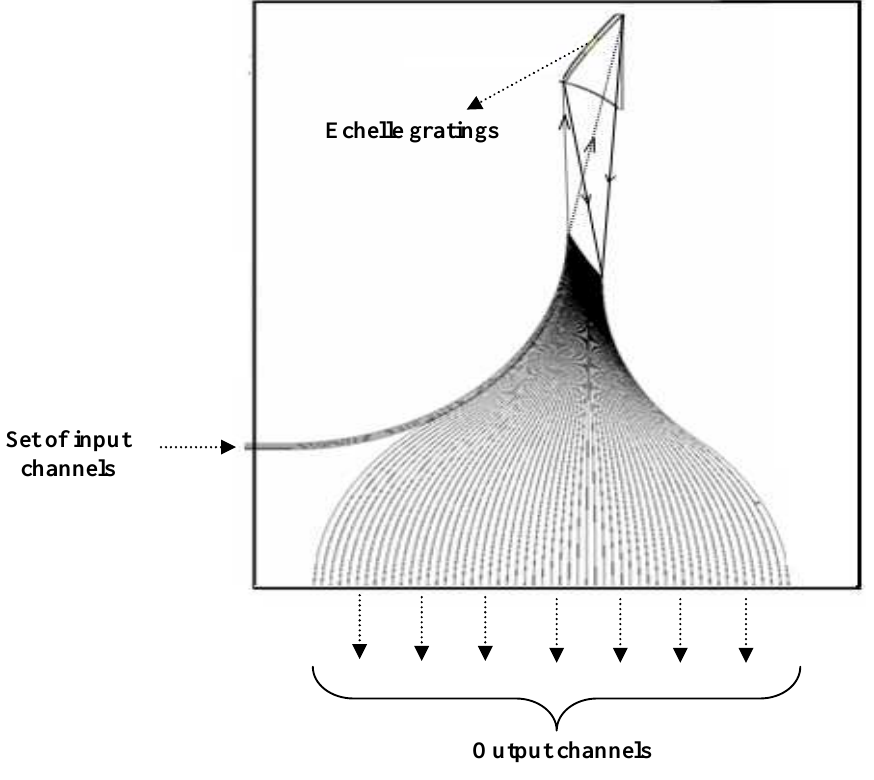
Figure 11. Schematic illustration of the Spectrometer-on-chip